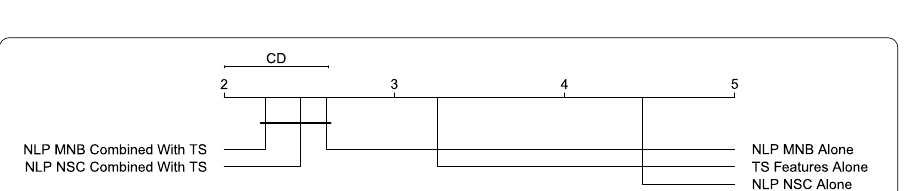
Figure 24 Critical Difference Diagram for negative test log loss scores obtained from Time Series Method (TS NSC light preprocessing) and NLP Methods alone, and from the combined methods